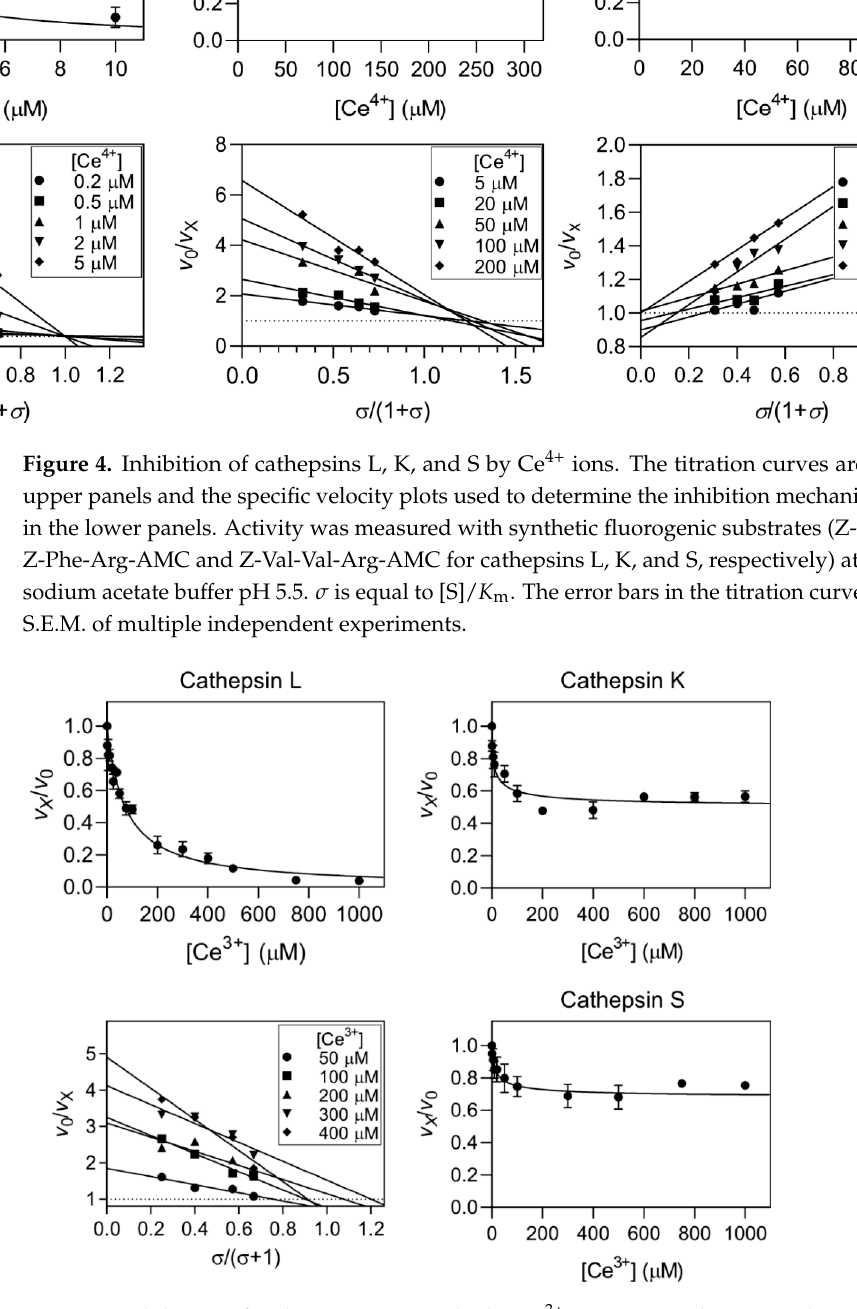
Figure 5. Inhibition of cathepsins L, K, and S by Ce 3+ ions. For cathepsin L, the titration curve is shown in the upper panel and the specific velocity plot is shown in the lower panel. For cathepsins K and S, only the titration curves are shown. Activity was measured using synthetic fluorogenic substrates (Z-Leu-Arg-AMC, Z-Phe-Arg-AMC and Z-Val-Val-Arg-AMC for cathepsins L, K, and S, respectively) at 25 °C in 0.1 M sodium acetate buffer pH 5.5. σ is equal to [S]/ K m . The error bars in the titration curves represent the S.E.M. of multiple independent experiments.